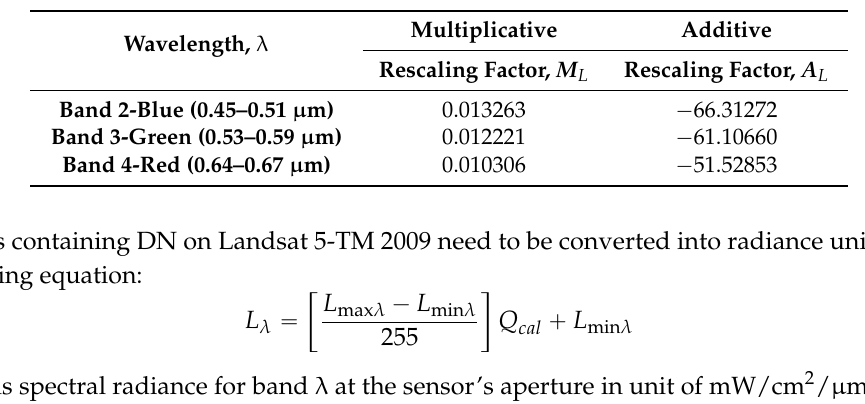
Table 2. Band multiplicative and additive rescaling factors of Landsat 8 (OLI).